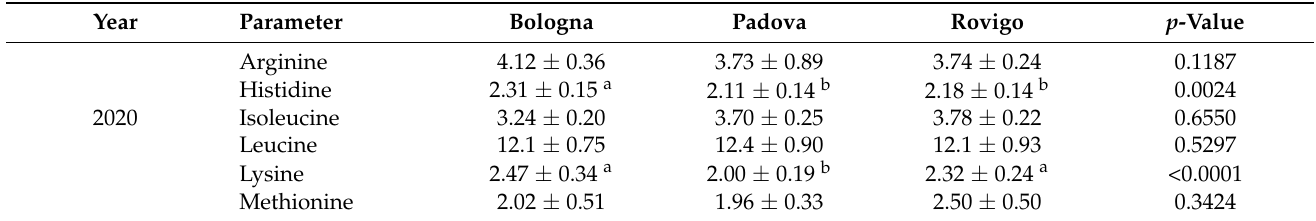
Table 2. Amino acid content (g per 100 g protein) of sorghum from different locations and years ( n = 15 per location and year; mean ±